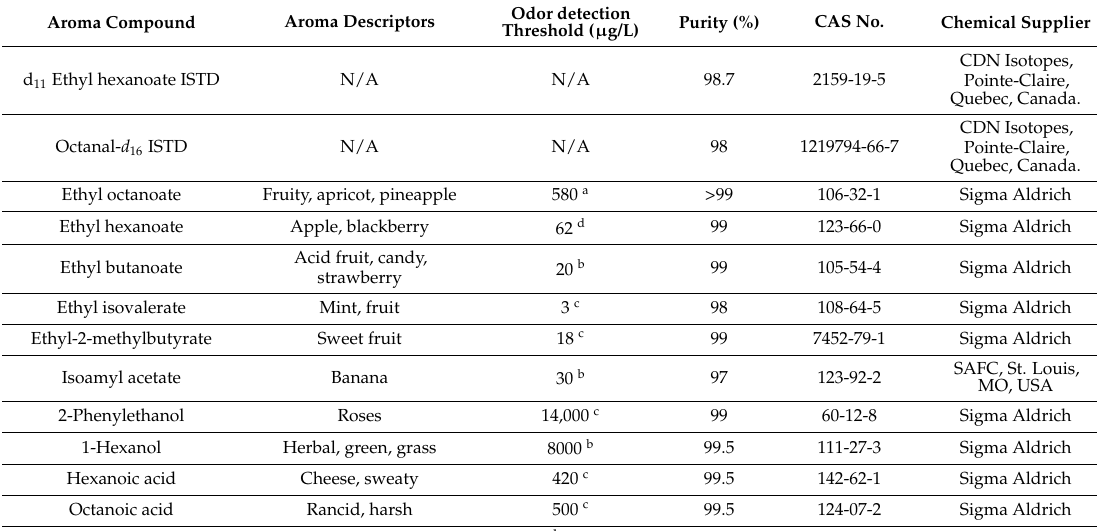
Table 2. Aroma descriptors, odor detection thresholds, purity, CAS numbers and suppliers of the volatile aroma compounds analysed.